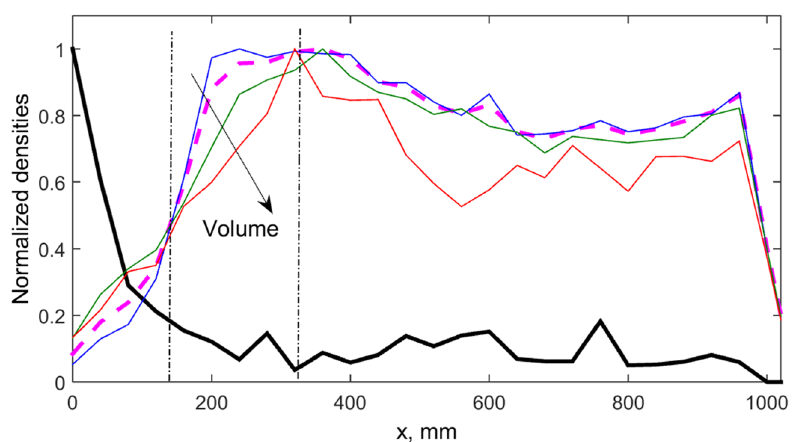
Figure 9. Density distributions of the food and animals at presence of regularly applied “waves of fear”. The densities of the food and animals are shown by the solid black and dashed magenta curves respectively. The curves for the densities of large, middle and small individuals are plotted by the same colors as above. The density shift with increasing size is marked by the